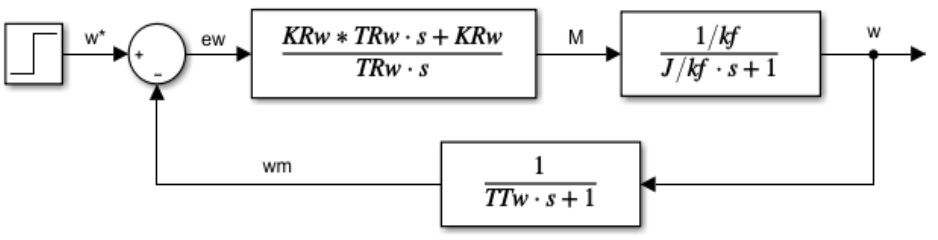
Figure 1. Block diagram of the linear control system.